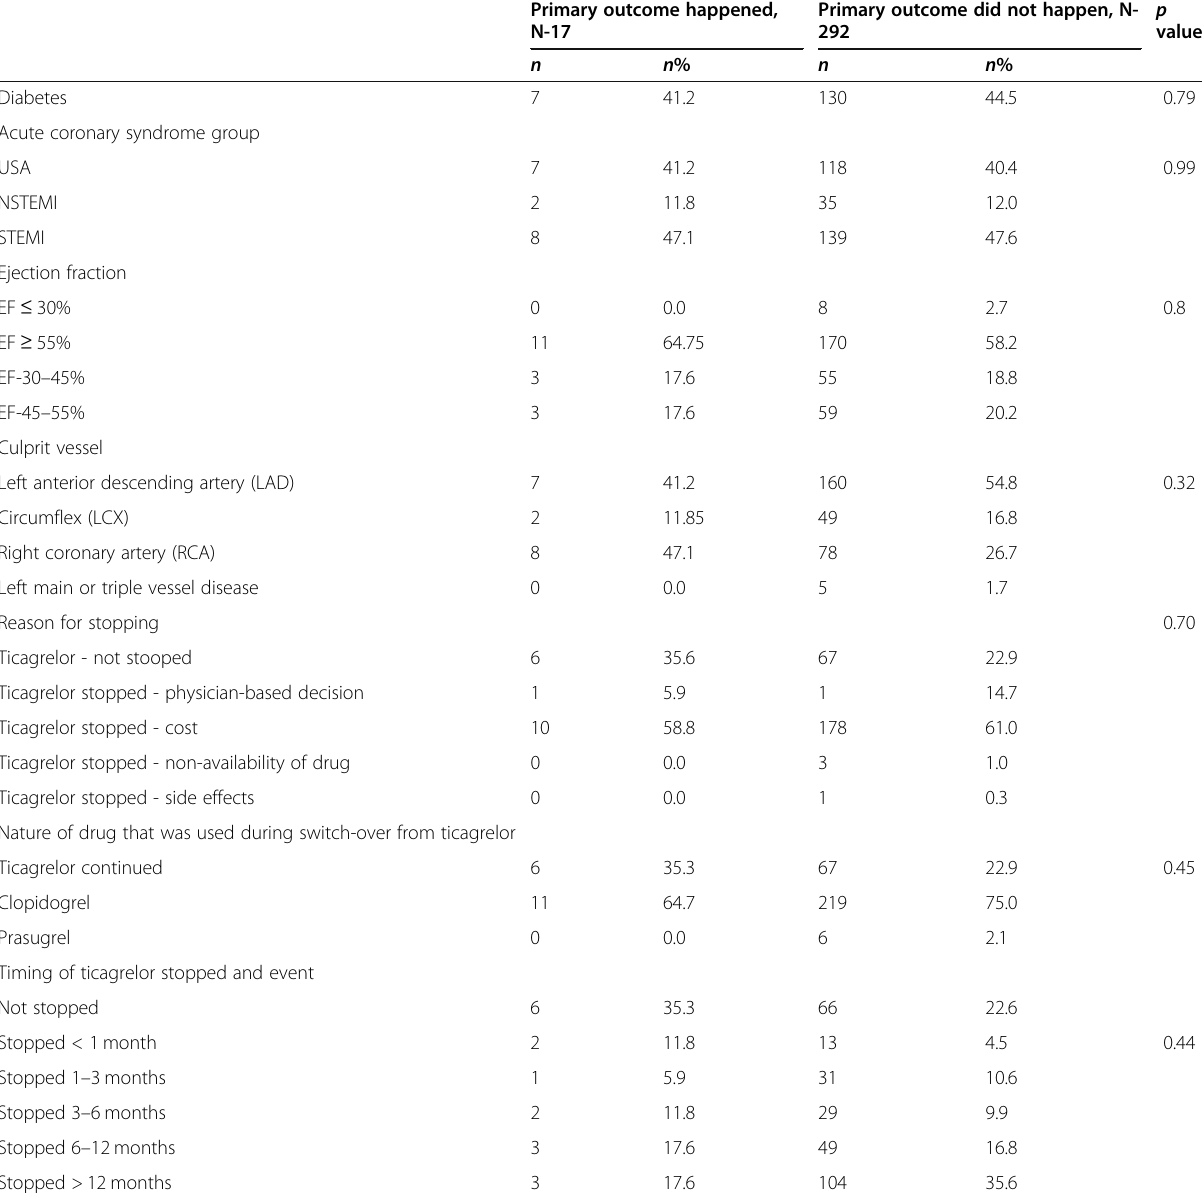
Table 5 Effect of various factors like diabetes, ACS, EF, reason for stopping ticagrelor, time of stopping ticagrelor, and nature of new drug added instead of ticagrelor on our primary outcome Primary outcome happened,